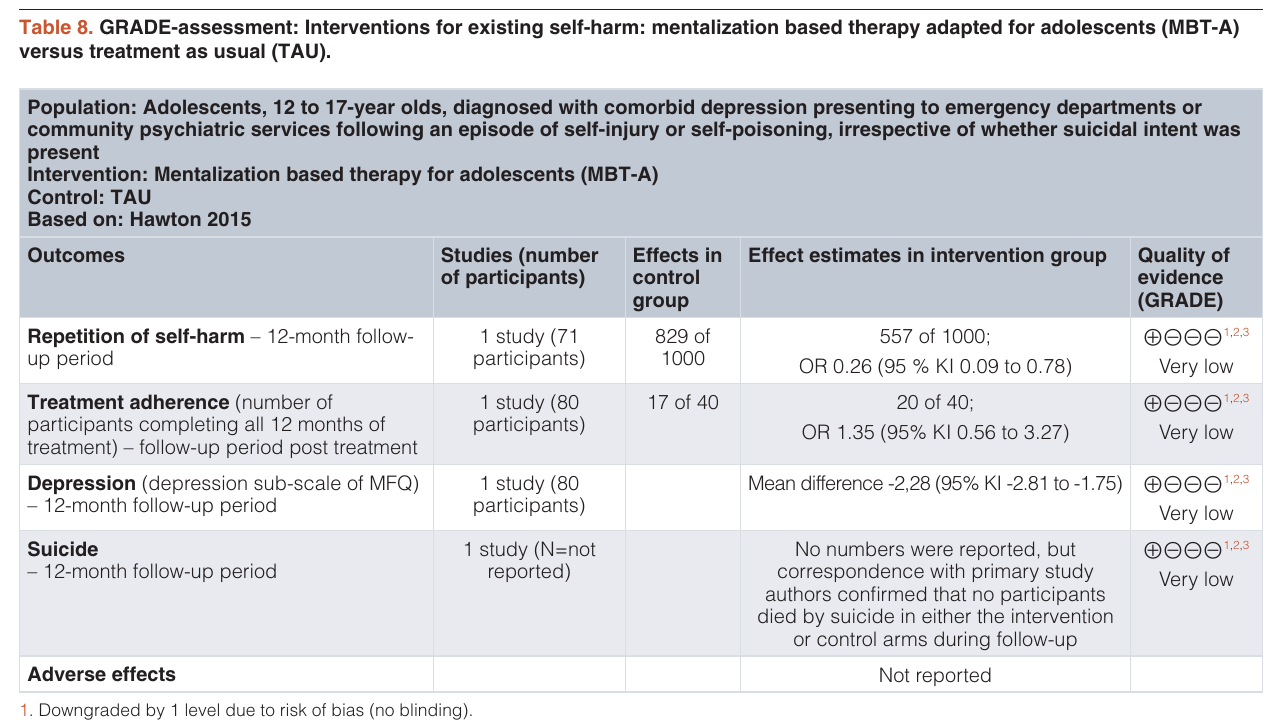
Interventions for existing self-harm: emergency green cards plus TAU versus TAU . The evidence contains one study with 105 adolescents between the ages of 12 and 16 who were admitted to hospital following an episode of self-injury or self- poisoning 31 . The intervention was emergency green cards in addition to usual care. The green card acted as a passport to re-admission into a paediatric ward at the local hospital. Length of treatment was 12 months. Follow-up period was 12